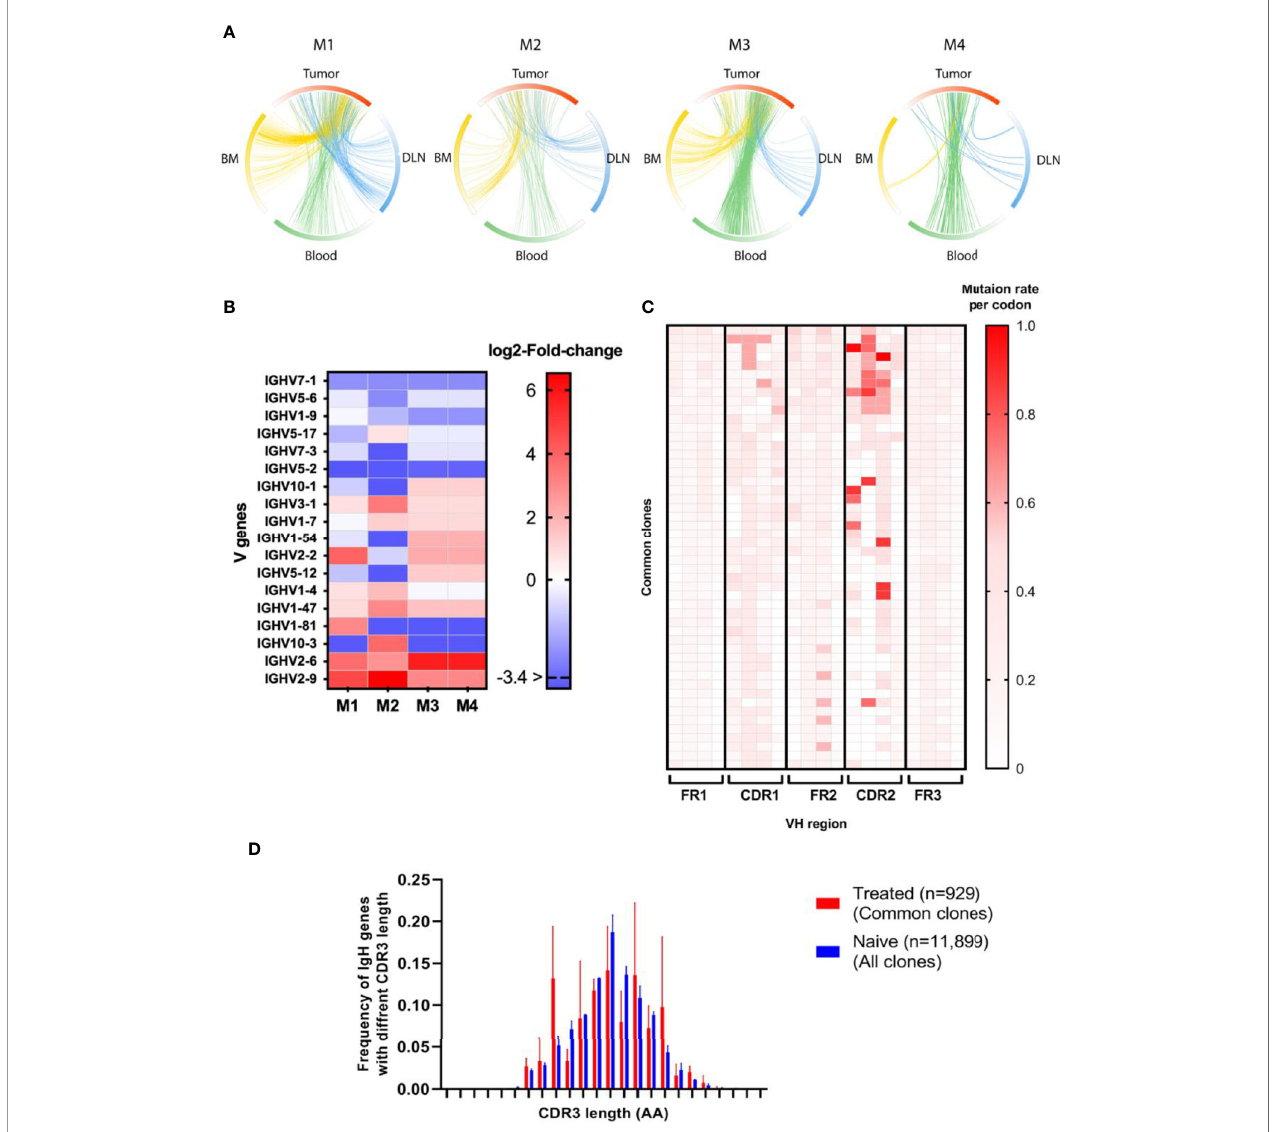
FIGURE 5 | Antibody repertoire measures for the common clones. (A) Circos plots showing the clonal distribution of TIL-Bs between tissues. M1-4 indicate a circos plot for each mouse. The circos plot arcs are colored by gradients that are in accordance with the frequency of the clone within each tissue. Each connecting line represents a clone that is common between two tissues. Red - tumor, blue - DLN, green - blood, yellow - bone marrow. Details regarding the number of common clones are listed in Supplementary Table S4 (B) Heat map showing log 2 fold-change of V gene frequencies between clone as identi fi ed in the bone marrow of naïve mice and common clones as identi fi ed in treated mice. Each column represents a mouse (M1-4) and each row, a V gene. Red gradient represents signi fi cantly higher frequency of V gene in the treated mice, while the blue gradient represents a signi fi cantly lower frequency of the V gene in the treated mice. Adjusted p values were considered signi fi cant using multiple correction test using Dunn – S ̌ ida ́ k correction method (C) Heat map of the SHM rate per codon for each V H region in the common clones. The red color indicates a higher SHM rate; each row represents one common clone; and each column represents a mouse. The heat map includes only the fi rst 50 dominant common clones from each mouse. (D) The distribution of V H genes with different CDRH3 lengths is shown in the bar graph. The average CDRH3 length of all the common clones for the treated mice (red bars) was compared to that for the naïve clones (blue bars). Statistical signi fi cance was determined by using an unpaired t-test. The p-value is p = 0.4939, which is considered to be not statistically signi fi cant (not shown). Error bars represent the standard